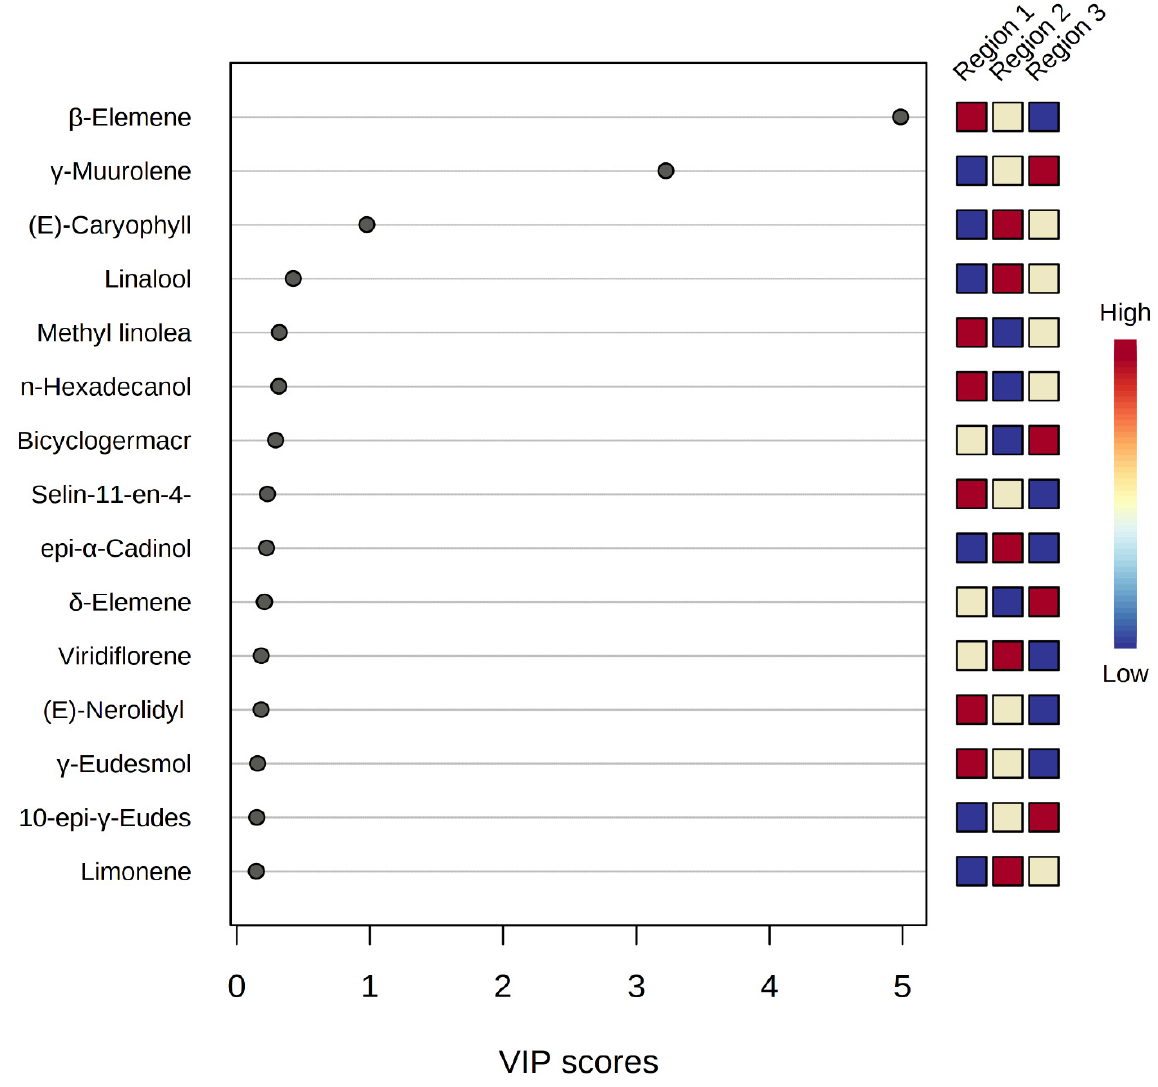
Figure 8. PLS-DA-VIP score plot showing important features of the major constituents of M. champaca leaf essential oil. The colored boxes on the right indicate the relative concentrations of the corresponding metabolite in each group under study.